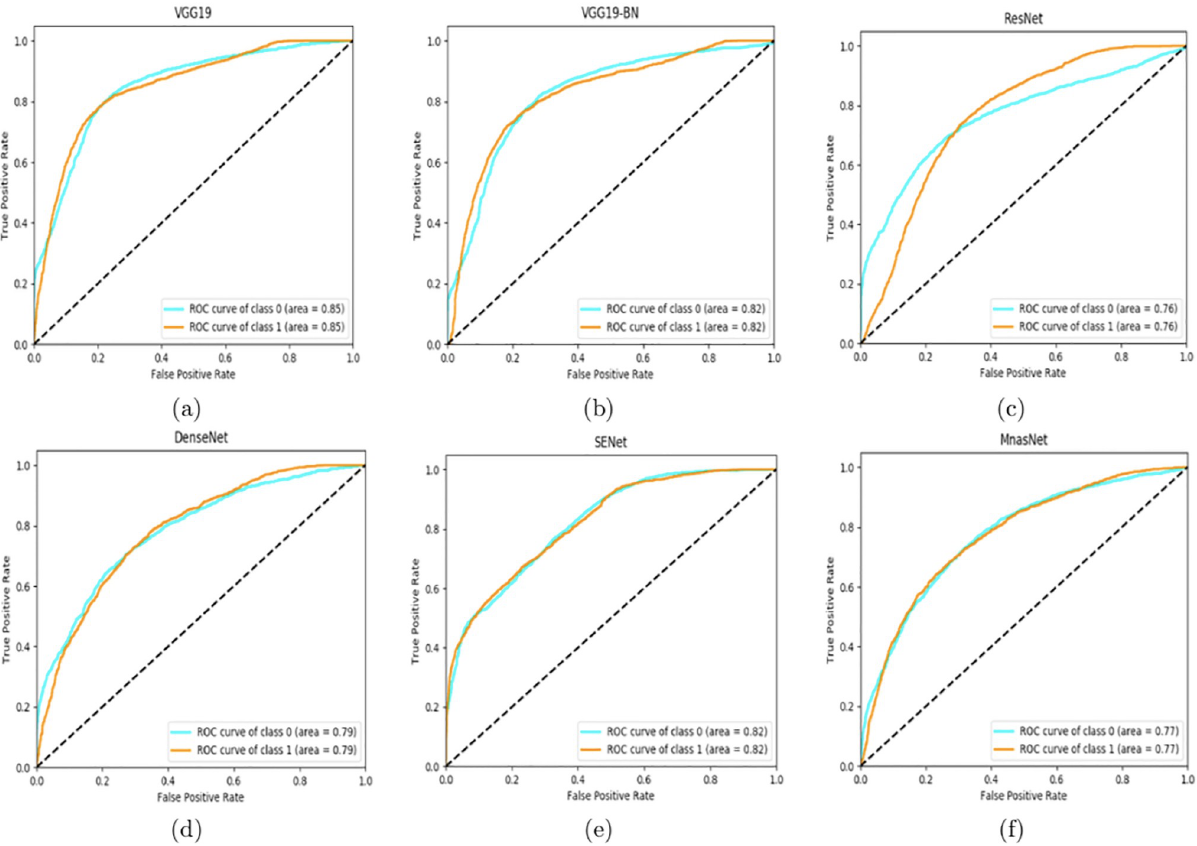
Fig 4. AUC-ROC curves of different models on set-2: (a) VGG19 (b) VGG19-BN (c) ResNet50 (d) DenseNet (e) SENet (f) MnasNet.